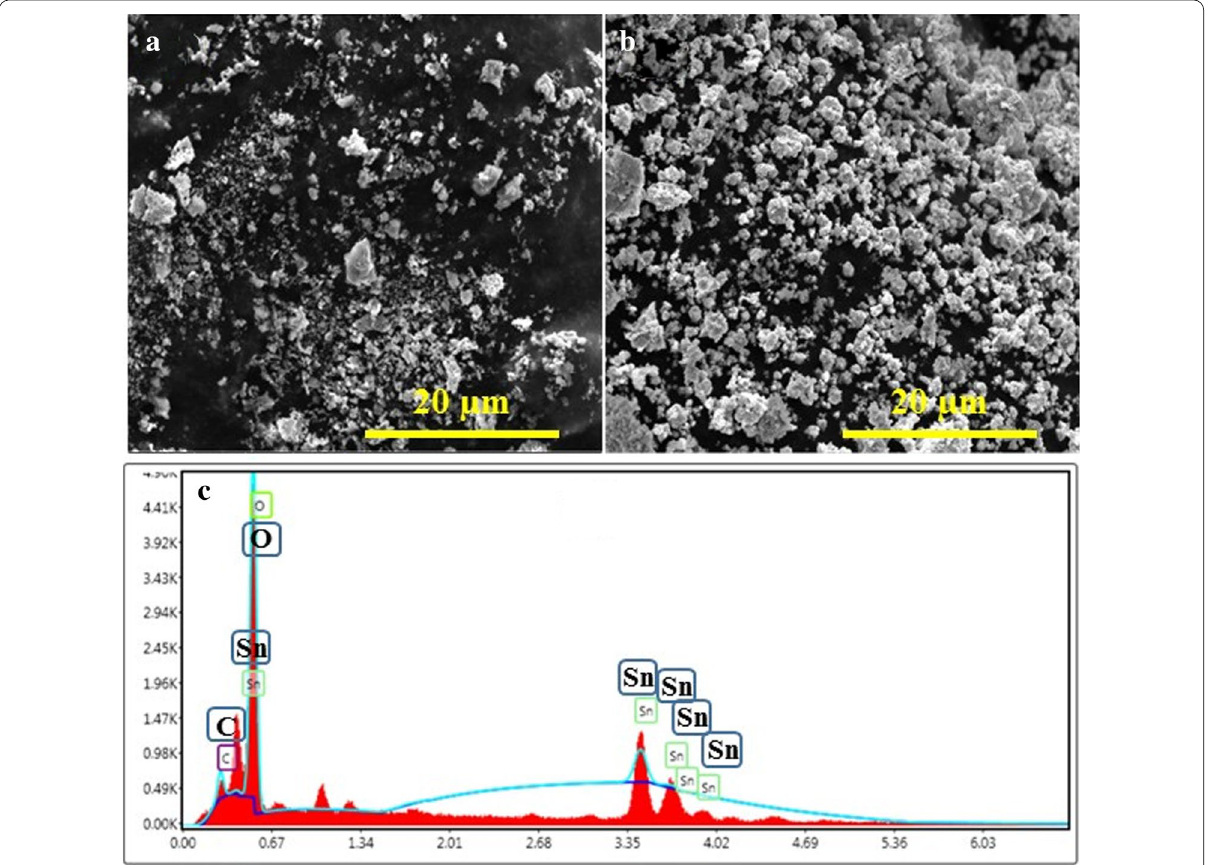
Fig. 7 FESEM micrographs from samples annealed at a 250 and b 750 °C and c EDX spectrum from sample annealed at 750